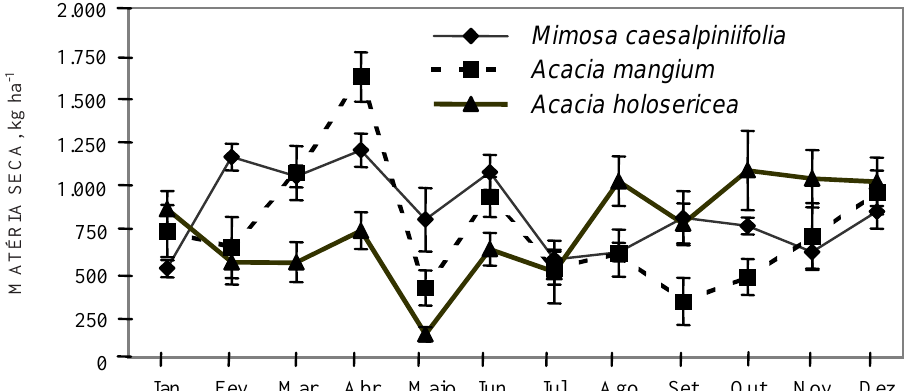
Figura 2. Deposição mensal de material formador da serapilheira de Mimosa caesalpiniifolia , Acacia mangium e Acacia holosericea . As barras junto às médias são seus